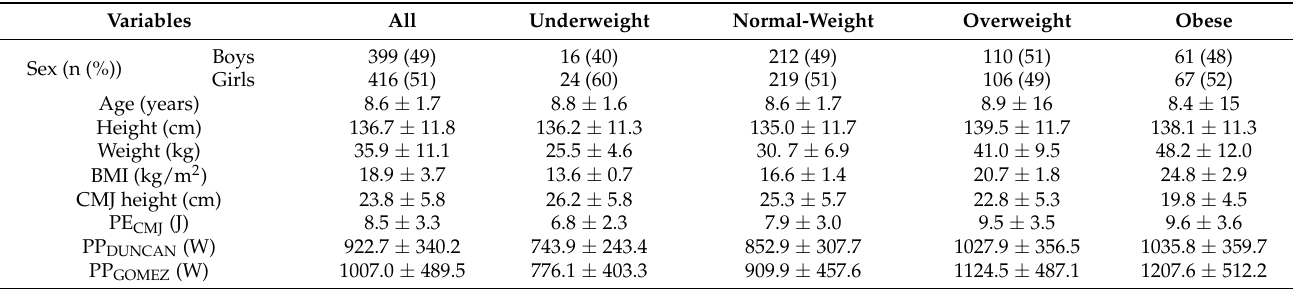
Table 1. Descriptive characteristics of the sample.